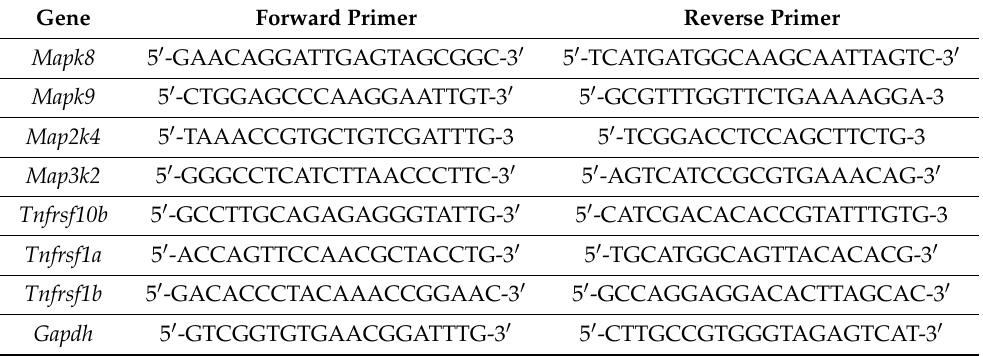
Table 1. Primers used for reverse transcription-polymerase chain